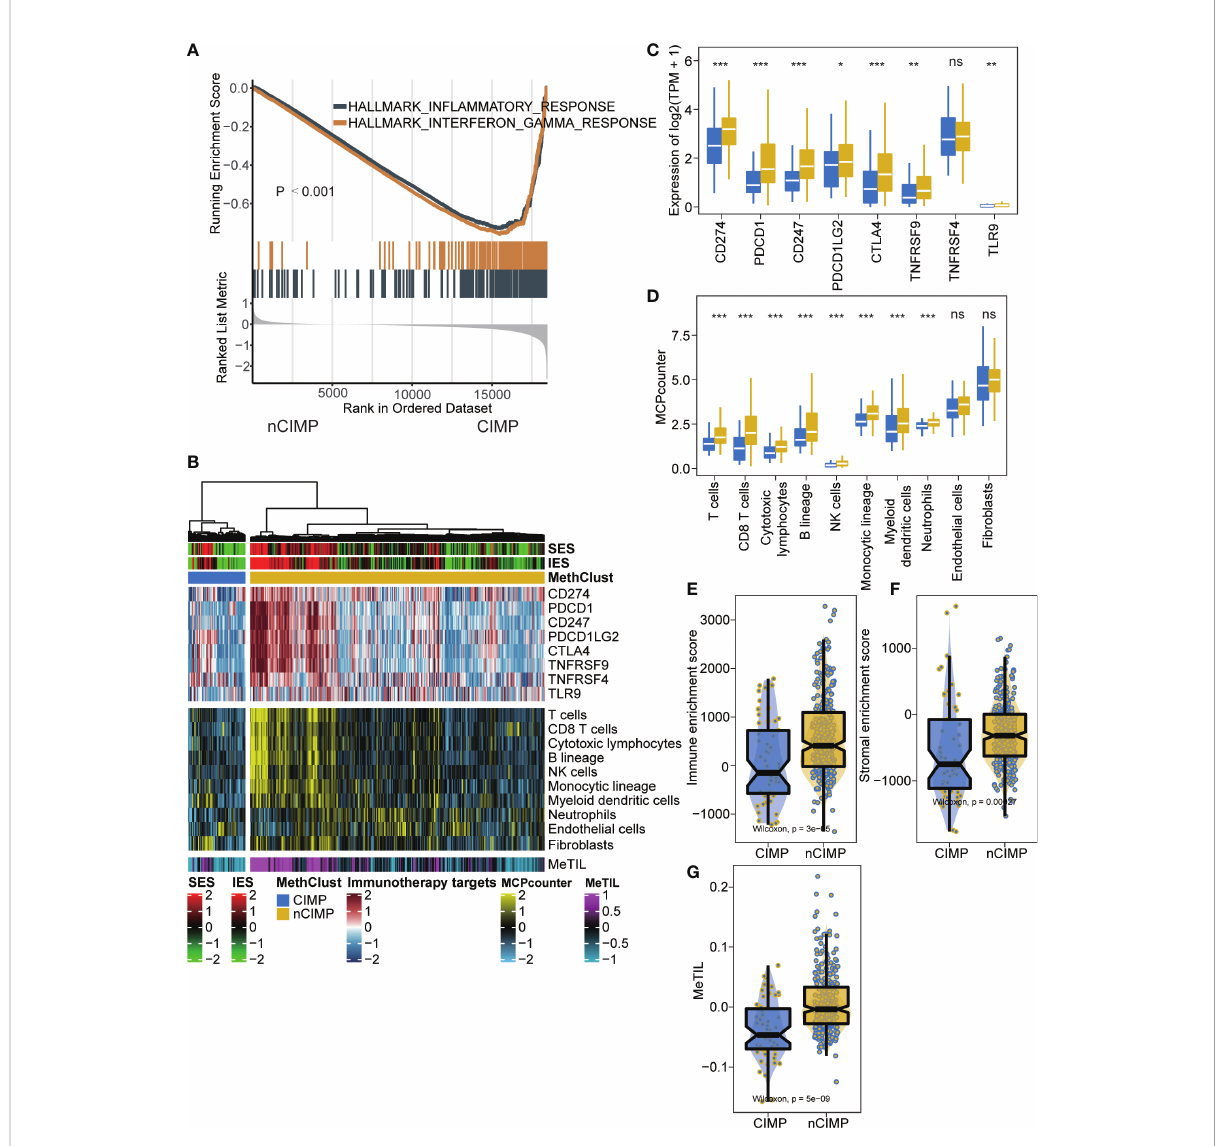
FIGURE 2 Tumor microenvironment landscape of CIMP. (A) GSEA plot showing inactivation of in fl ammatory response and interferon- g . (B) Heatmap showing the immune pro fi le in the TCGA-PTC cohort, with the top panel showing the expression of genes involved in immune checkpoint targets, the middle panel showing the enrichment level of 10 microenvironment cell types, and the bottom panel showing the DNA methylation of tumor-in fi ltrating lymphocytes (MeTILs). The immune enrichment score and stromal enrichment score were annotated at the top of the heatmap. (C) Boxplot showing the distribution of expression of immune checkpoint target genes between two epigenetic phenotypes. (D) Boxplot showing the distribution of enrichment score of 10 microenvironment cell types between two epigenetic phenotypes. Distribution of immune enrichment scores, stromal enrichment scores and MeTIL scores between two epigenetic phenotypes were shown in (E – G) , respectively (ns stands for no signi fi cance, *p < 0.05, **p < 0.01, ***p <